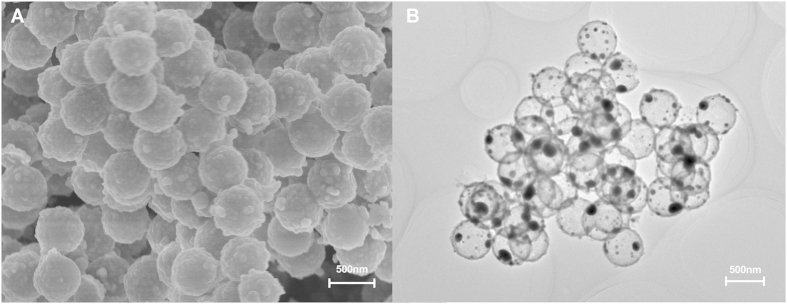
Electron microscopy micrograph of the Ag@SiO2 hollow nanoparticles.(A) Shows scanning electron microscopy micrograph; and (B) shows transmission electron microscopy micrograph.